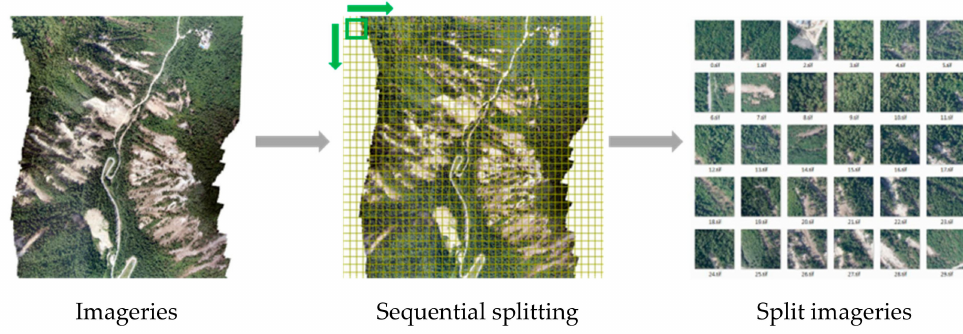
Figure 7. Dataset